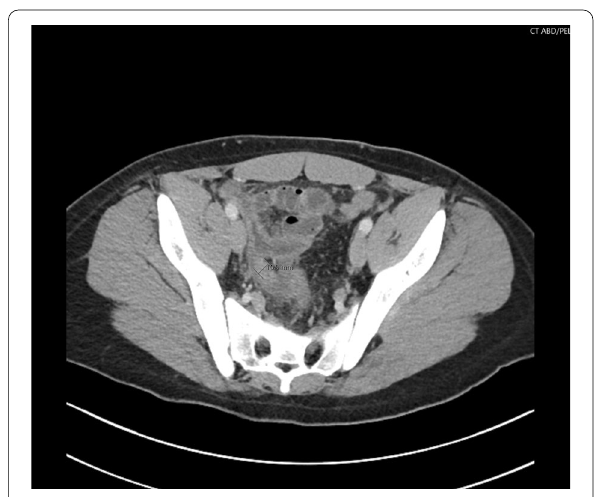
Fig. 1 Transverse view of the abdominal CT demonstrating 0.9‑mm dilated appendix with periappendiceal fluid in the pelvis